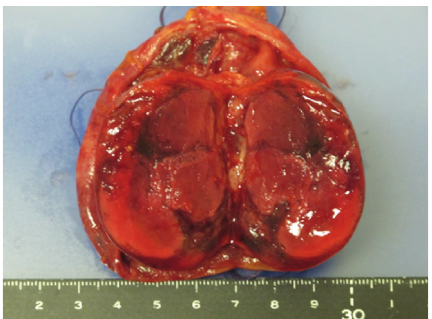
Figure2:Grossappearance.Outsidesurfacewasblackenedinspots; inside lumen was occupied by hematomas and necrotic tissue.